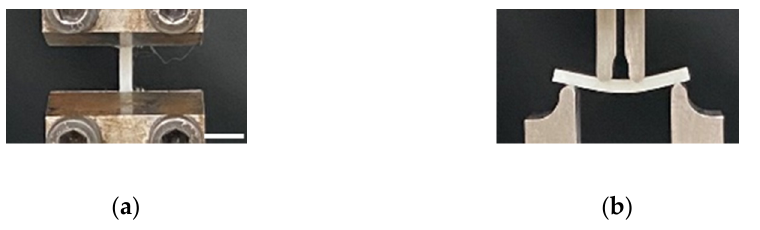
Figure A1. Photographs of the P. 100% test pieces in their jigs during loading for the ( a ) uniaxial tensile test ( ε T = 0.05) and ( b ) four-point flexural test ( ε F = 0.2). Bar: 10 mm.